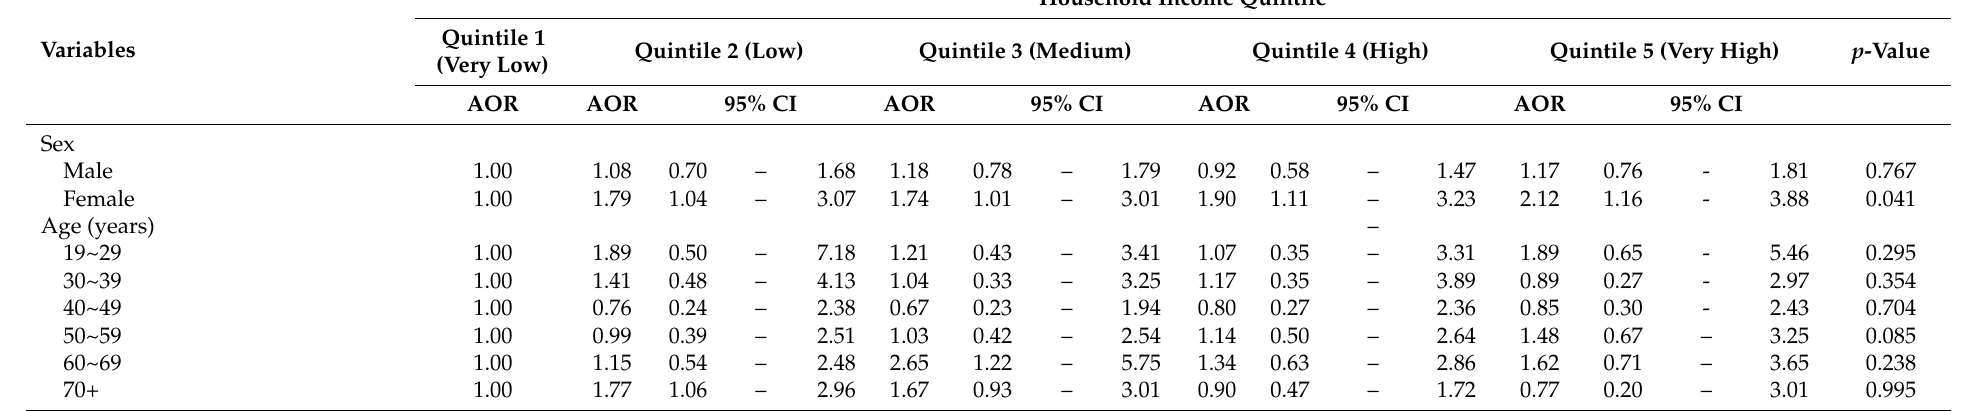
Table 4. Subgroup analysis of overall mineral intake suitability by logistic regression analysis. For each subgroup, every criterion shown in the table below except for the one corresponding to the subgroup was analyzed. Each quintile group was compared with quintile 1. Adjusted odds ratio (AOR)s, 95% confidence intervals (CI), and trend p -values are shown. BMI: Body Mass